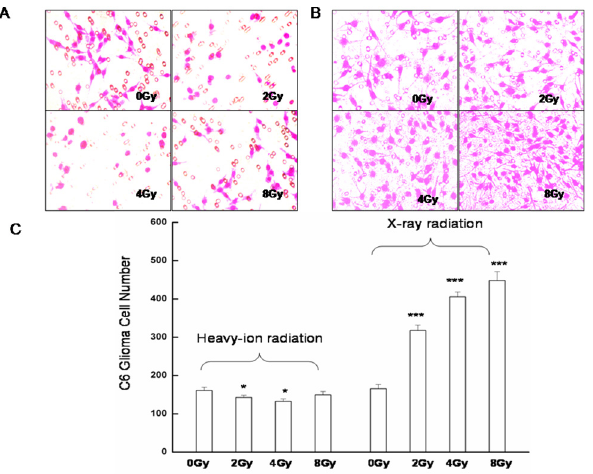
Fig 1. Effect of radiation on tumor cell migration as assessed by the Boyden chamber migration assay. Representative images are shown of migrating C6 glioma cells exposed to conditioned medium from cultures of A. unirradiated or heavy ion-irradiated, or B. unirradiated or X-ray-irradiated glioma cells. C. Quantification of the number of migratory glioma cells is expressed as means ± standard error of the mean from three independent experiments, in which treatments were performed in triplicate. * P < 0.05, *** P < 0.001 vs. controls (0 Gy).